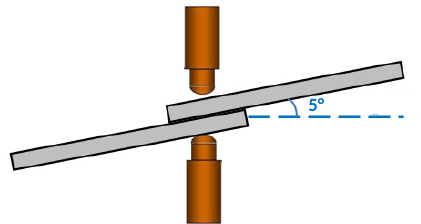
Figure 3. 5 ◦ misalignment between the electrodes and the